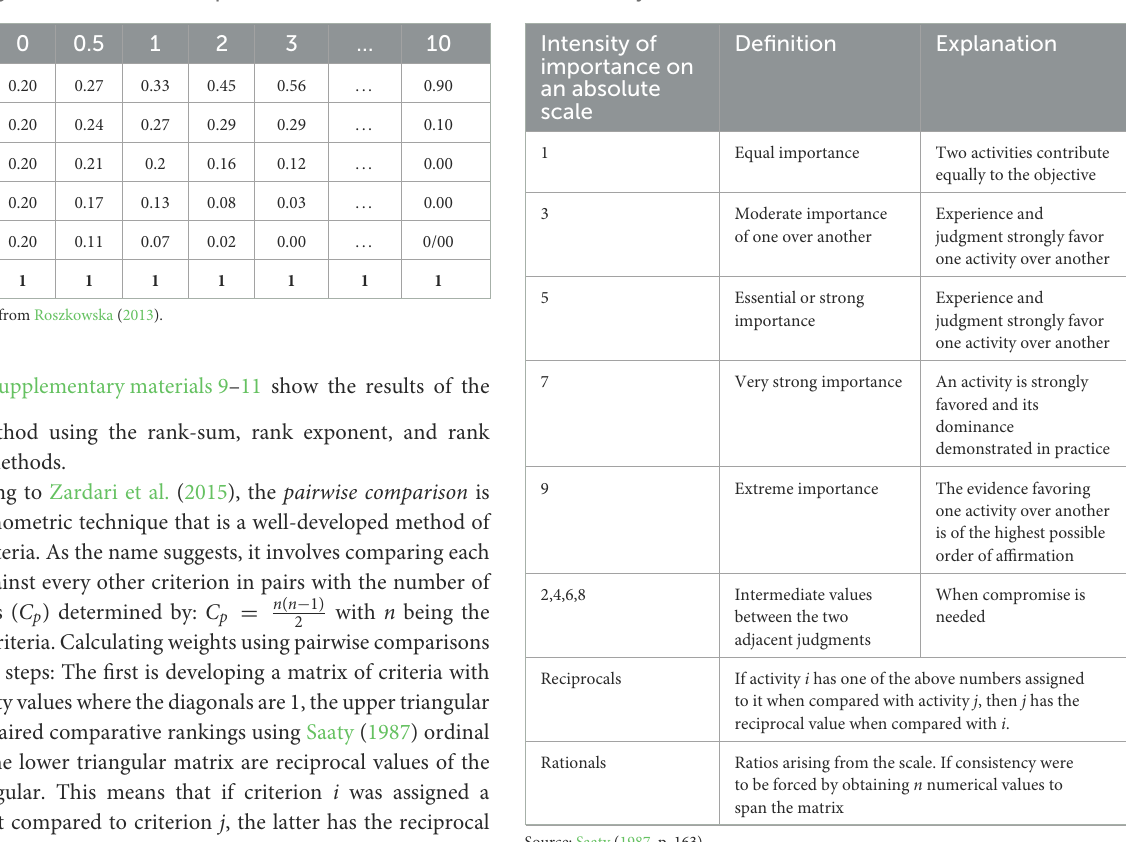
TABLE 3 Weight distributions of rank exponent